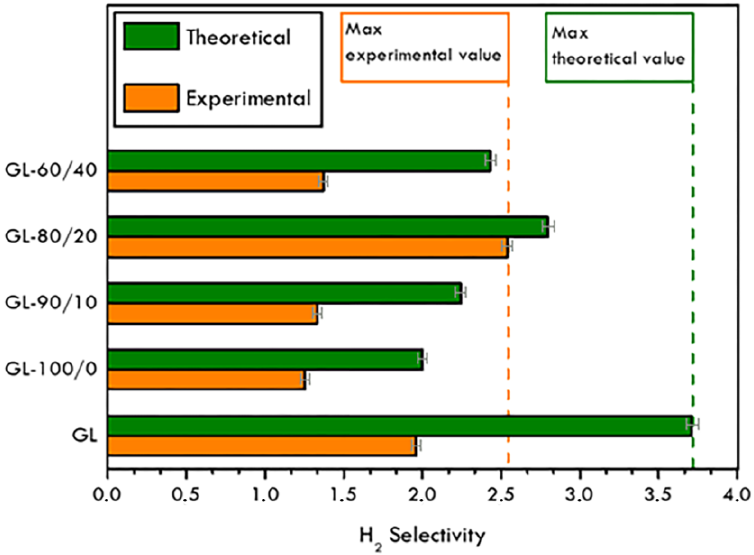
Figure 11. Theoretical and experimental H 2 selectivity values for analysed